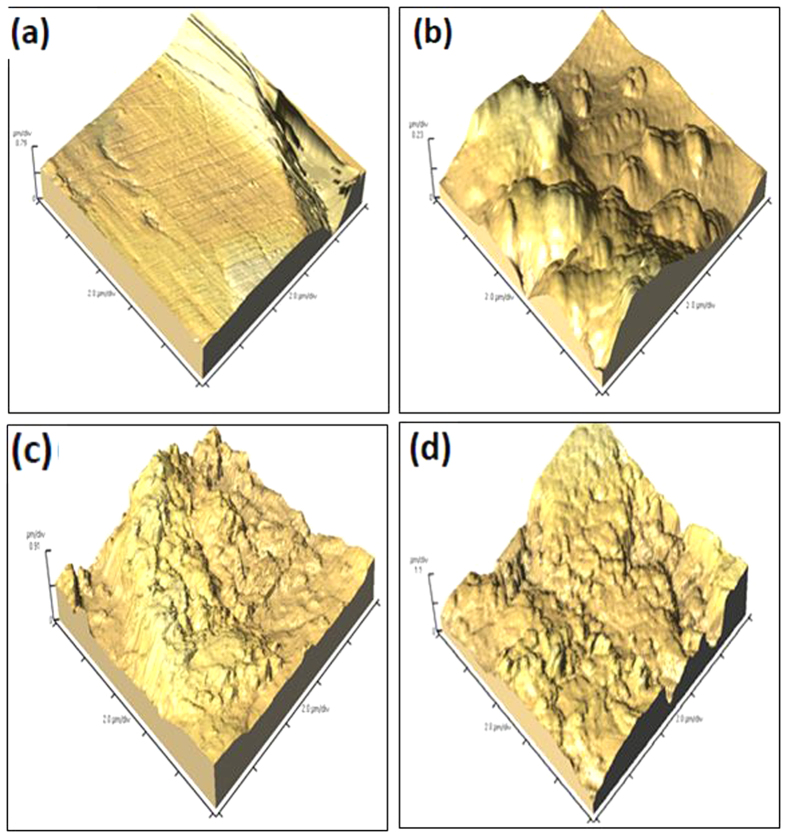
Atomic force micrograph of (a) plain MS surface, (b) MS in 0.5 M H2SO4, (c) MS in 0.5M H2SO4+ 1600 ppm PNVP-PU (d) MS in 0.5M H2SO4 + 1600 ppm PDMAEMA-PU.